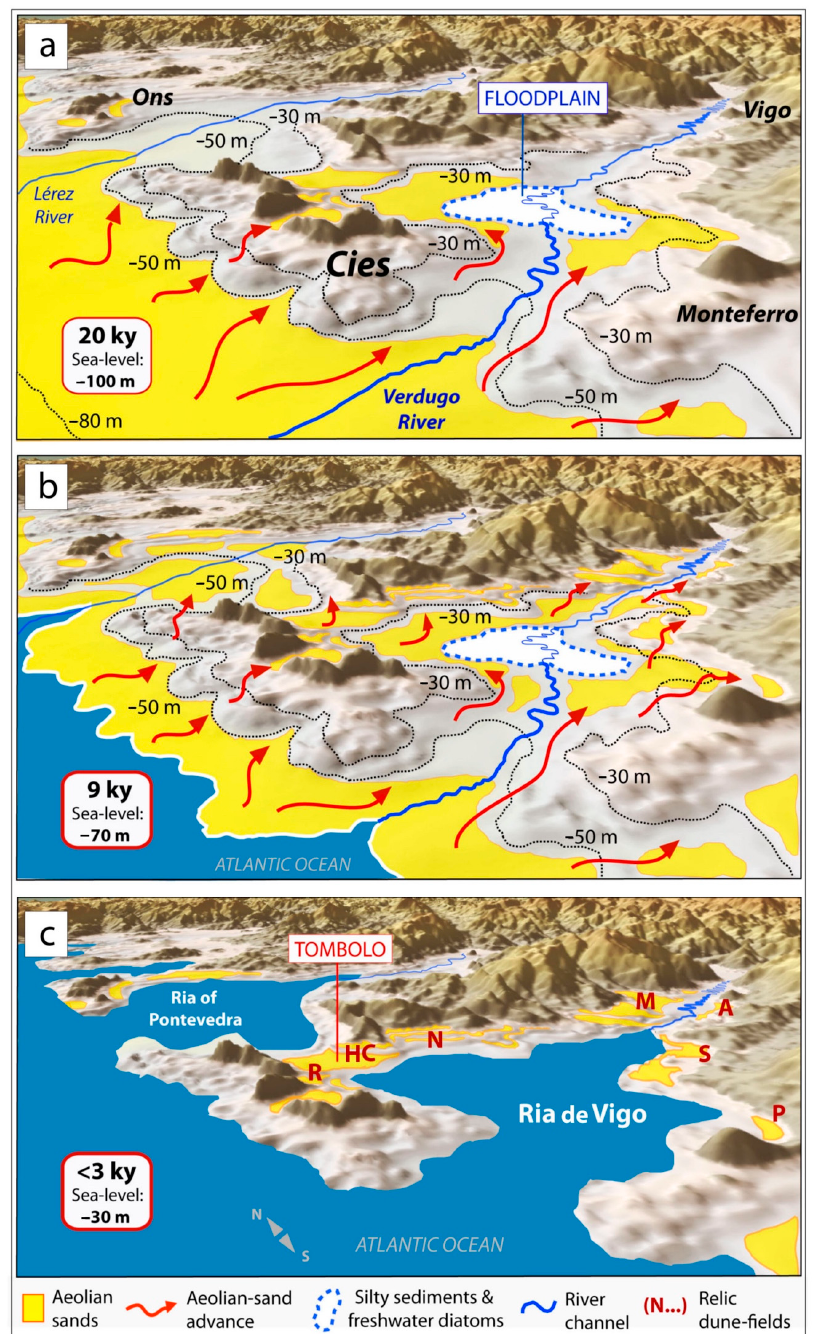
Figure 10. Sequence of the aeolian accretion process in the fluvial valley of Verdugo River at the end of the Last Glacial period, showing the hypothetical sand dunes advance towards the continent (red arrows) and subsequently sea-level rise in the last post-glacial transgression: ( a ) 20 ky aeolian sands advanced through the emerged continental platform and the Cies Islands from a sea-level below − 100 m (bpsl); ( b ) 9 ky sea-level about − 70 m (bpsl), with the aeolian sands upwards within the fluvial valley; ( c ) incipient configuration of the Ria de Vigo with a sea-level about − 30 m (bpsl) from less than 3 ky, flooding the aeolian sands and the river plain. Capital letters indicate aeolian sands that are related to the relict aeolian formations (as dune fields and climbing dunes) currently preserved around the ria: Rodas (R), Home Cape (HC), Nerga (N), Moaña (M), Arenal-Vigo (A), Samil (S) and Patos